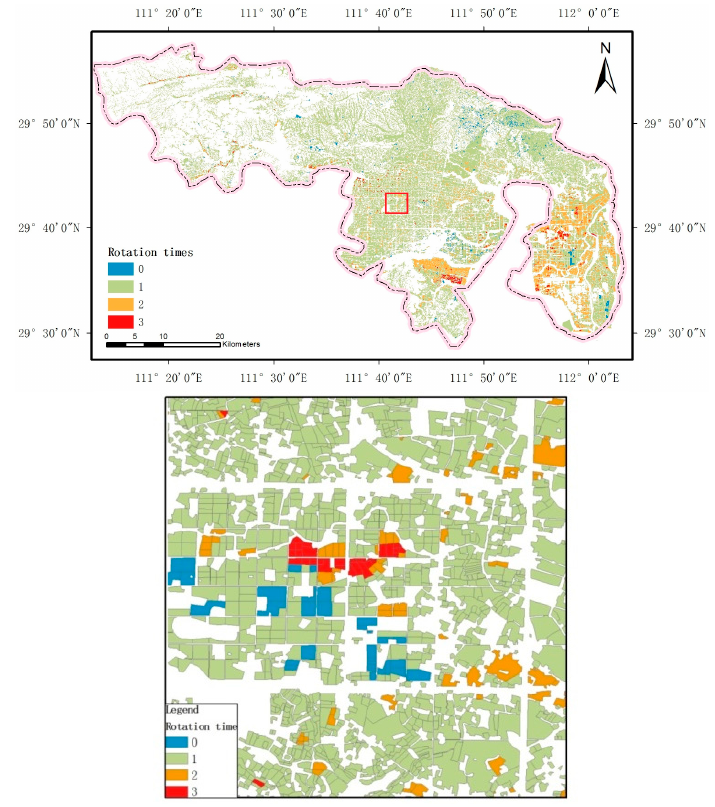
Figure 9. Spatial distribution of crop rotation.